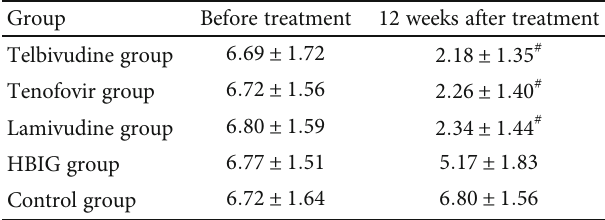
Table 2: The blood HBV DNA levels in study subjects. Group Before treatment